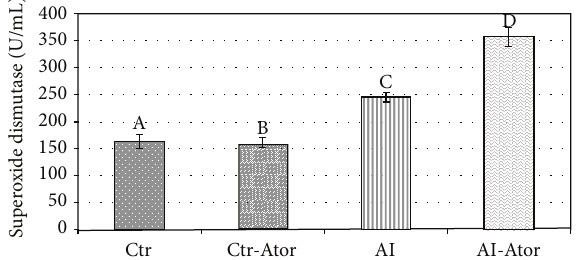
Figure 1: Plasmatic fibrinogen values in rats with induced HF treated with atorvastatin ( 𝑛 = 12 ). Crt versus Ctr.Ator ND; Ctr versus AI 𝑃 < 0.0001 ; Ctr versus AI-Ator 𝑃 < 0.001 ; Ctr-Ator versus AI 𝑃 < 0.001 ; Ctr-Ator versus AI-Ator 𝑃 < 0.0001 ; AI versus AI- Ator 𝑃 < 0.001 .